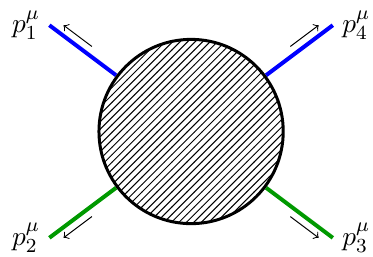
Figure 1. Schematic representation of a 2 → 2 scattering process involving two objects with masses m (blue) and m 1 2